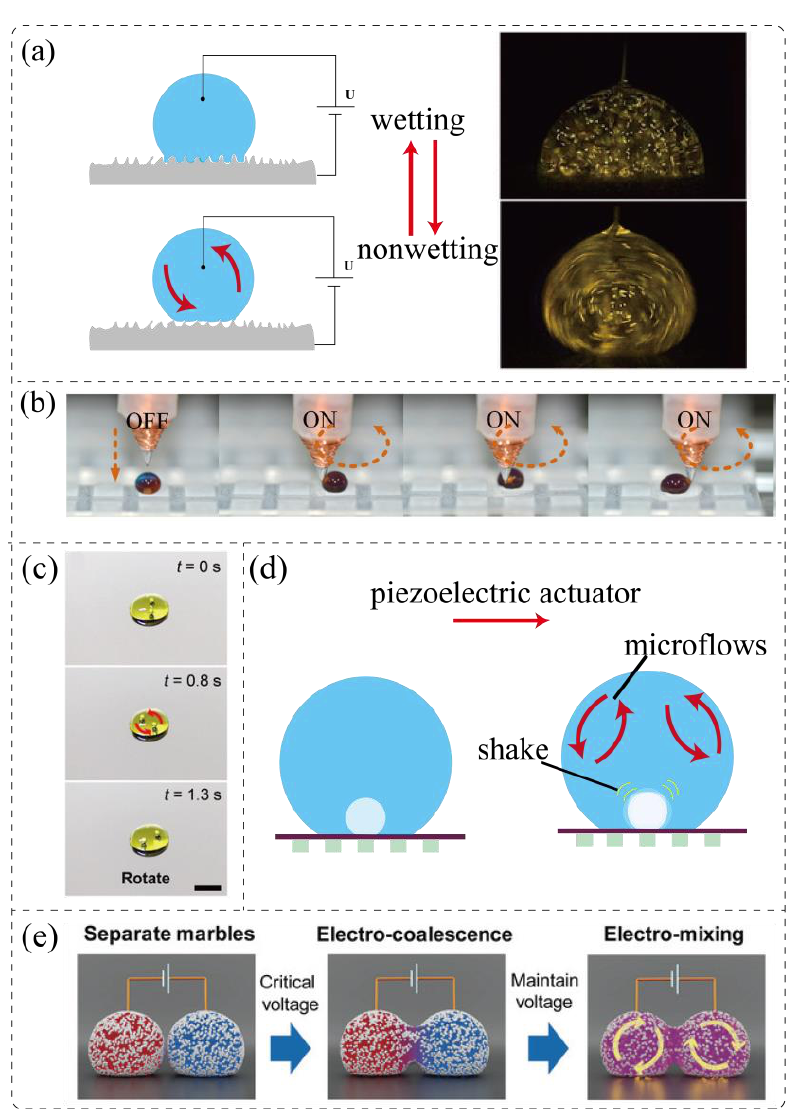
Figure 14. ( a ) The mixing is caused by the switching of droplets between wetting and nonwetting states [138] (Reproduced with permission from Springer Nature, 2008). ( b , c ) Acceleration of mixing in droplets caused by the internal rotation of magnetic particles [100,117] (Reproduced with permission from Elsevier, 2017; American Association for the Advancement of Science, 2020). ( d ) The efficient mixing is assisted by acoustic bubbles [139]. ( e ) The detailed process of LMs from the separate state, coalescing state until mixing state, under a well-controlled electric field [140] (Reproduced with permission from John Wiley and Sons, 2019).